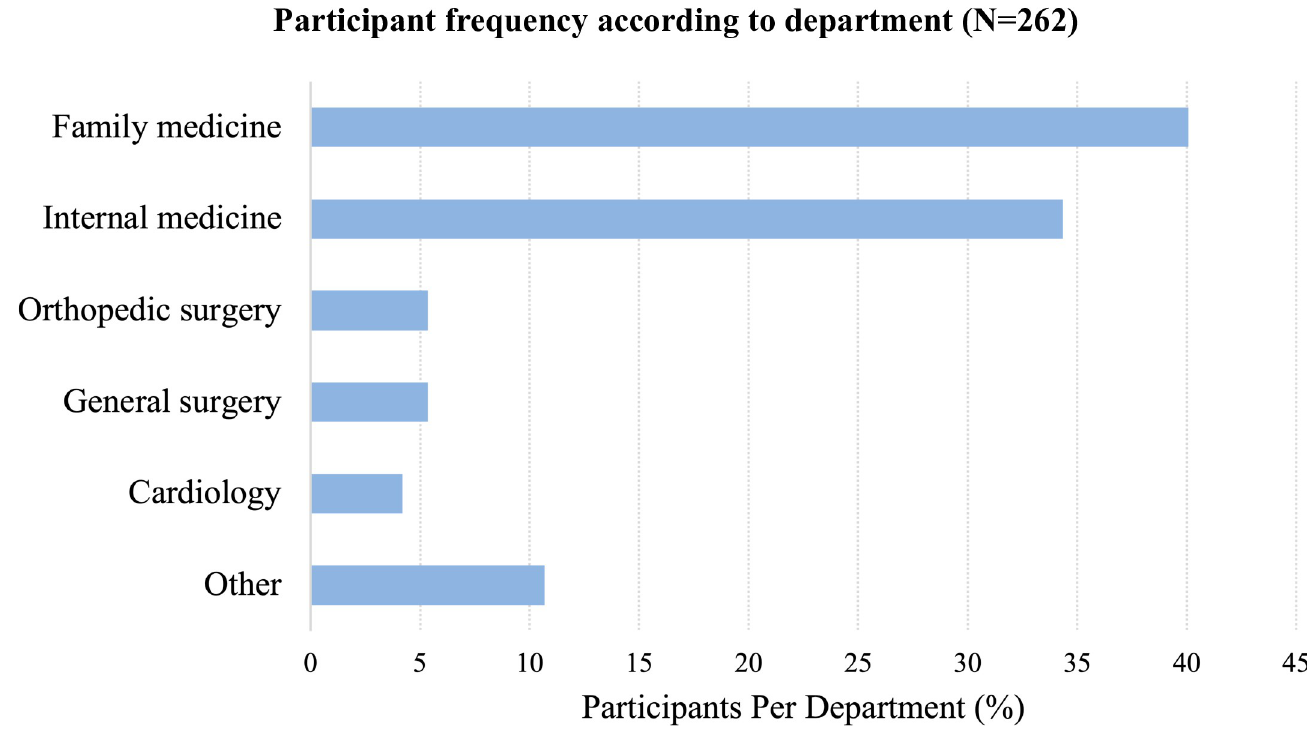
Fig 1. Participant frequency according to department (N = 262).